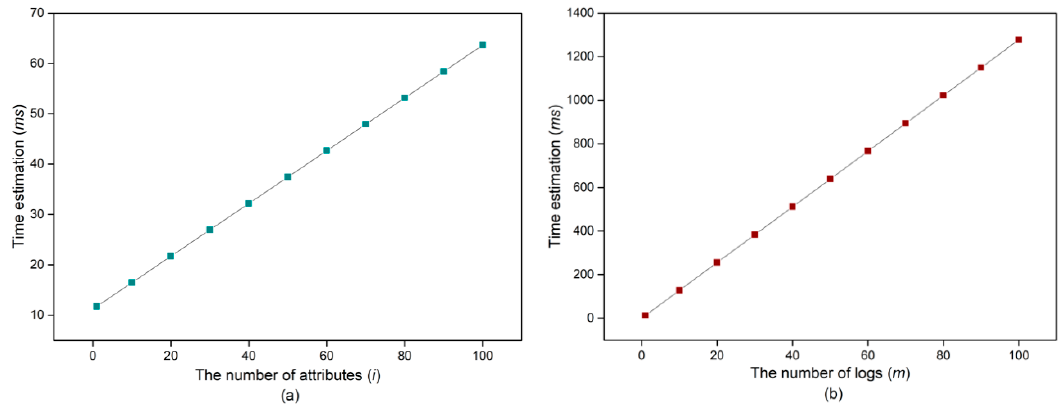
Figure 9. Total computation cost of the proposed protocol: ( a ) 𝑛 = 1 and 𝑚 = 1 ; ( b ) 𝑛 = 1 and 𝑖 = 3 .